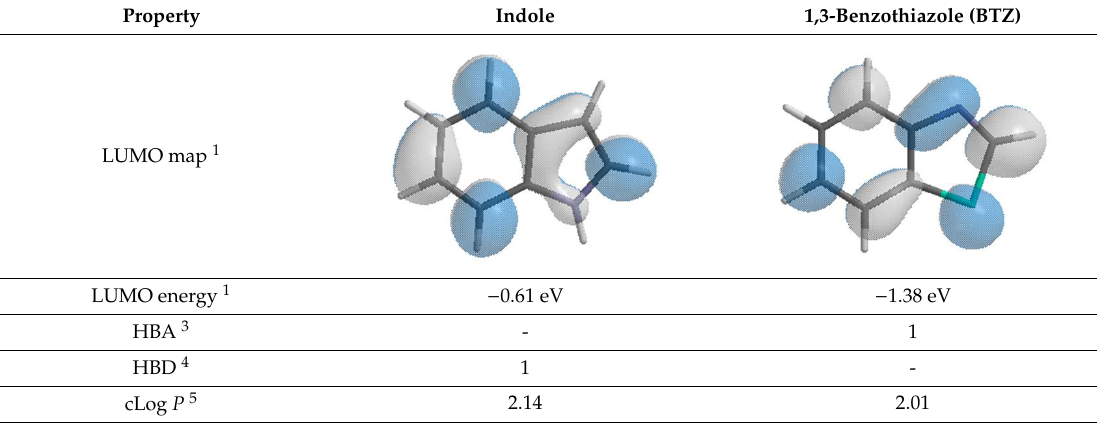
Figure 1. Common names and therapeutic applications of the 1,3-benzothiazole drugs included in DrugBank [3]; A: approved, I: investigational, E: experimental, W: withdrawn; each drug has been color-coded as follows: yellow = etiotropic agent, magenta = drugs acting on CNS, white = diagnostic, and blue = pharmacodynamic agent (see text for details).